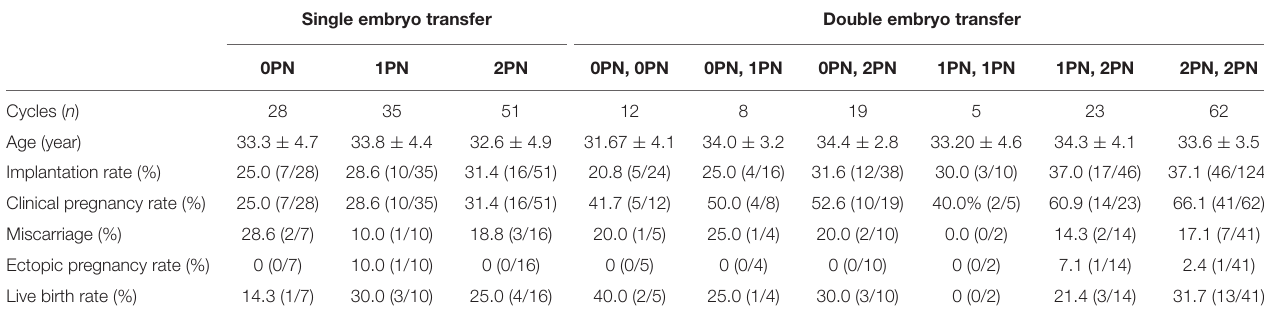
TABLE 6 | Comparison of blastocyst transferred cycles resulting in clinical outcomes originated from discarded embryos. Single embryo